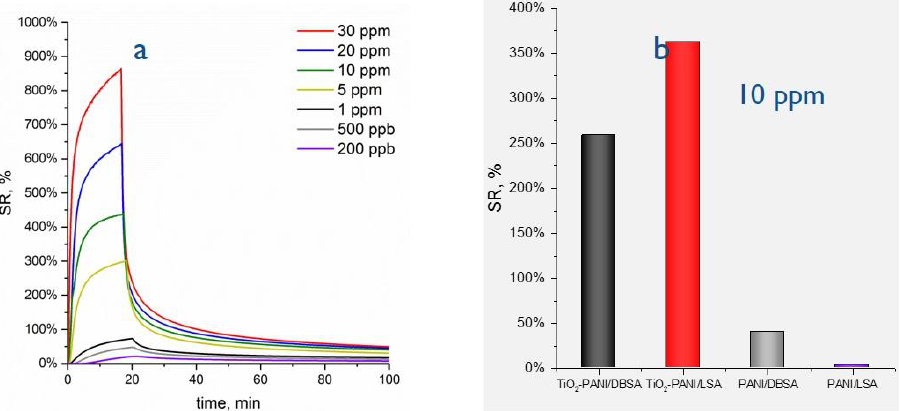
Figure 6. ( a ) Typical response of the hybrids to ammonia; ( b ) Comparison of the response of pure PANI and PANI-TiO 2 (doped with the same